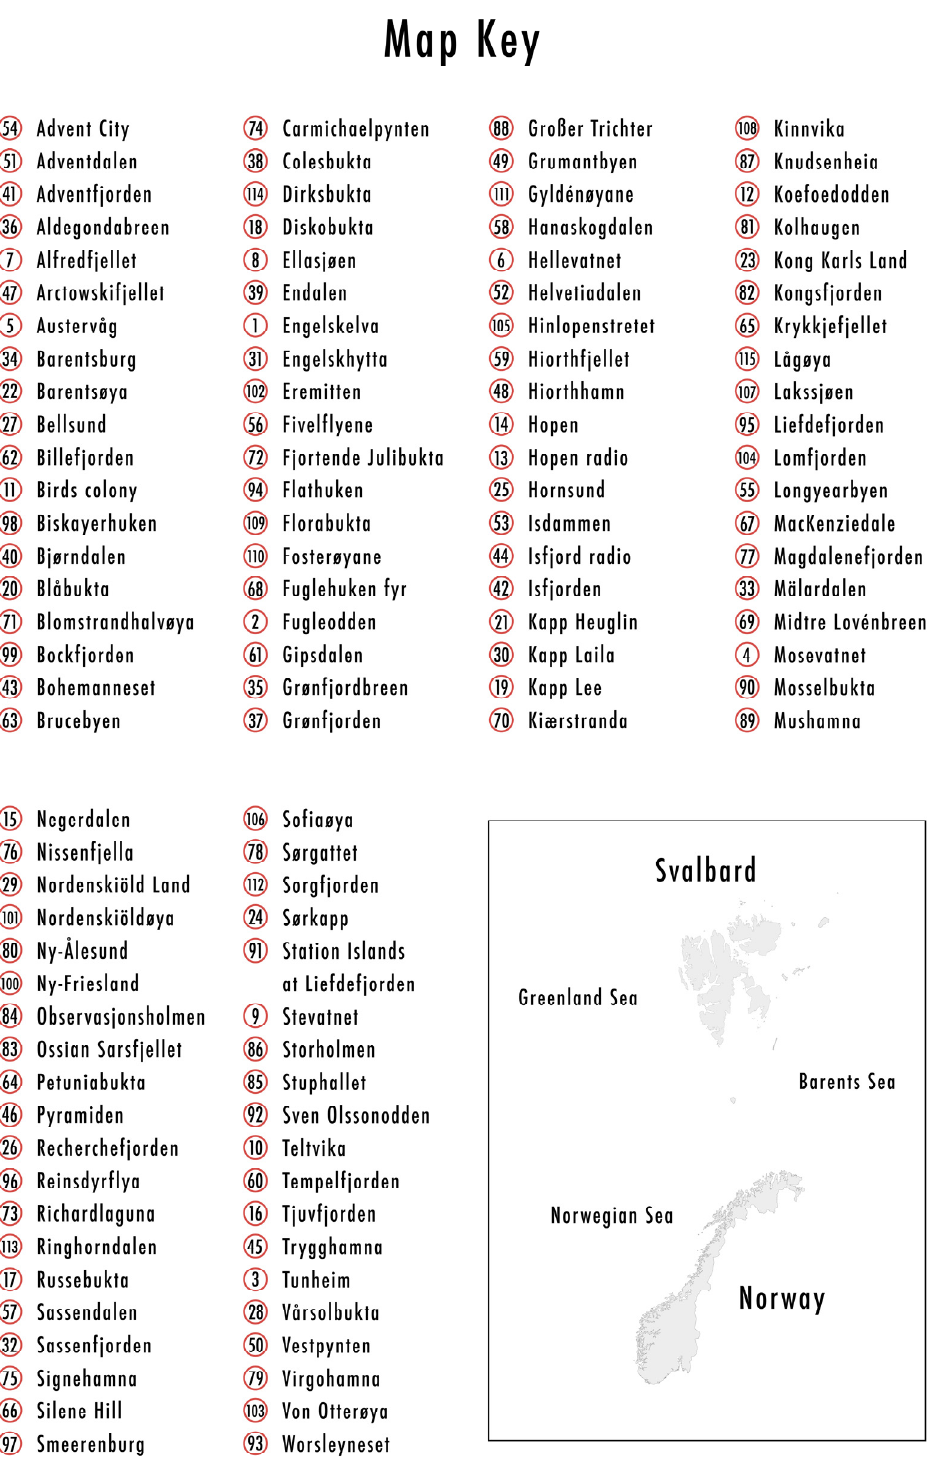
Figure 1. Localities in Svalbard where mites were found.